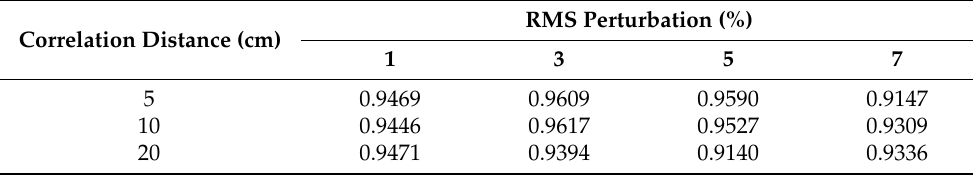
Table 1. Correlation coefficients between Yutu-2 LPR data and synthetic data.